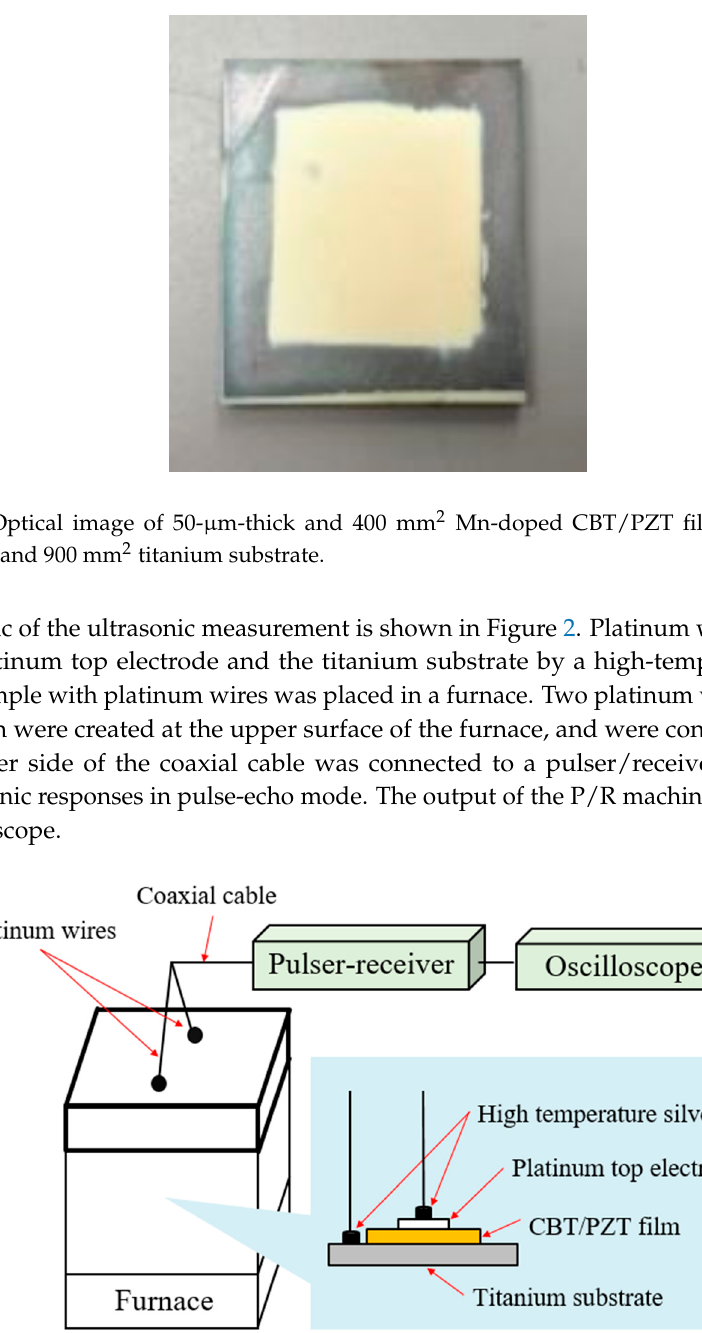
Figure 2. Schematic of ultrasonic measurement at elevated temperatures.